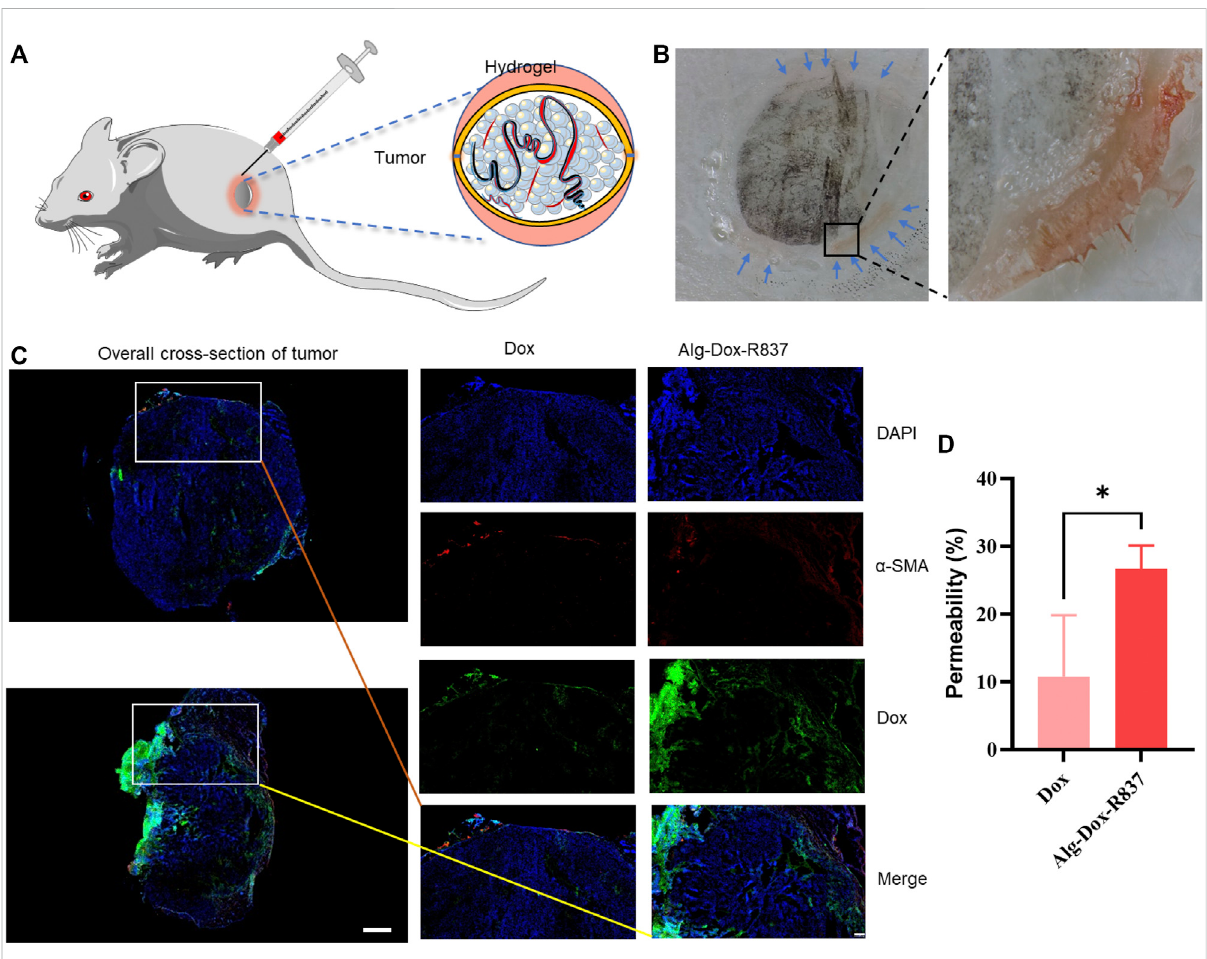
FIGURE 2 Subcutaneous interstitial administration of gel to achieve tumor wrap (A) Schematic diagram of interstitial injection of hydrogel to achieve tumor wrap; (B) Cryosection imaging of gel-wrapped tumor (black: melanoma, red: Alg-Dox -R837 gel); (C) Localized fl uorescence imaging